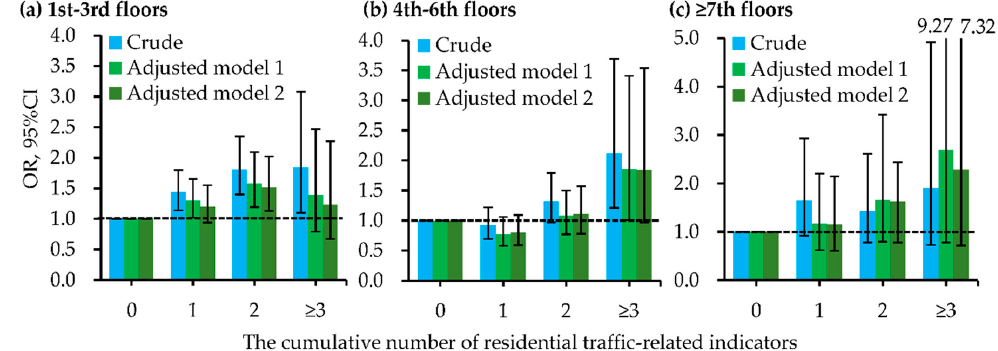
Figure 4. Dose-response relationships of the cumulative number of indictors for residential traffic within 200 m of the residence with odds of childhood pneumonia, stratified by bedroom floor level.